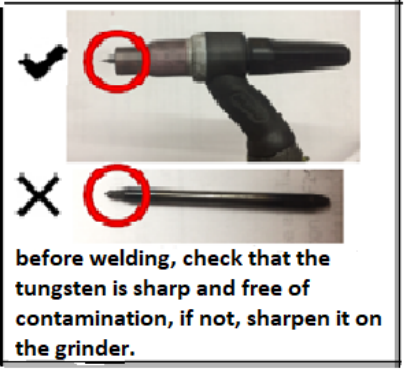
Figure 6. Work instruction to avoid the recurrence of the failure. Source: SOMSAC. Monitoring of the parameters β and η and the parameter λ for activities with critical failures. The relationship between the reliability index and the Weibull β and η parameters